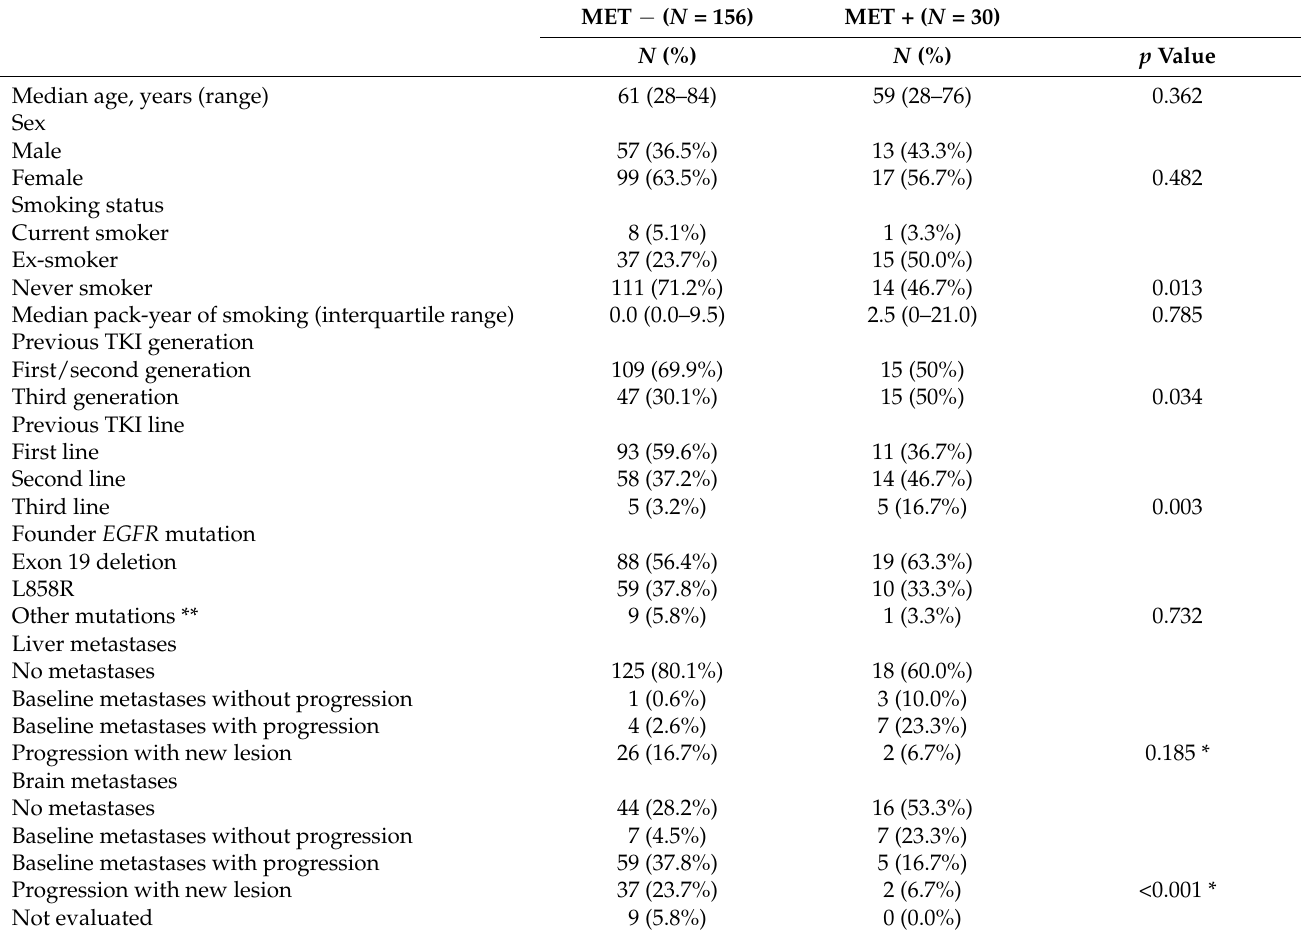
Table 1. Patient characteristics based on MET status ( N =